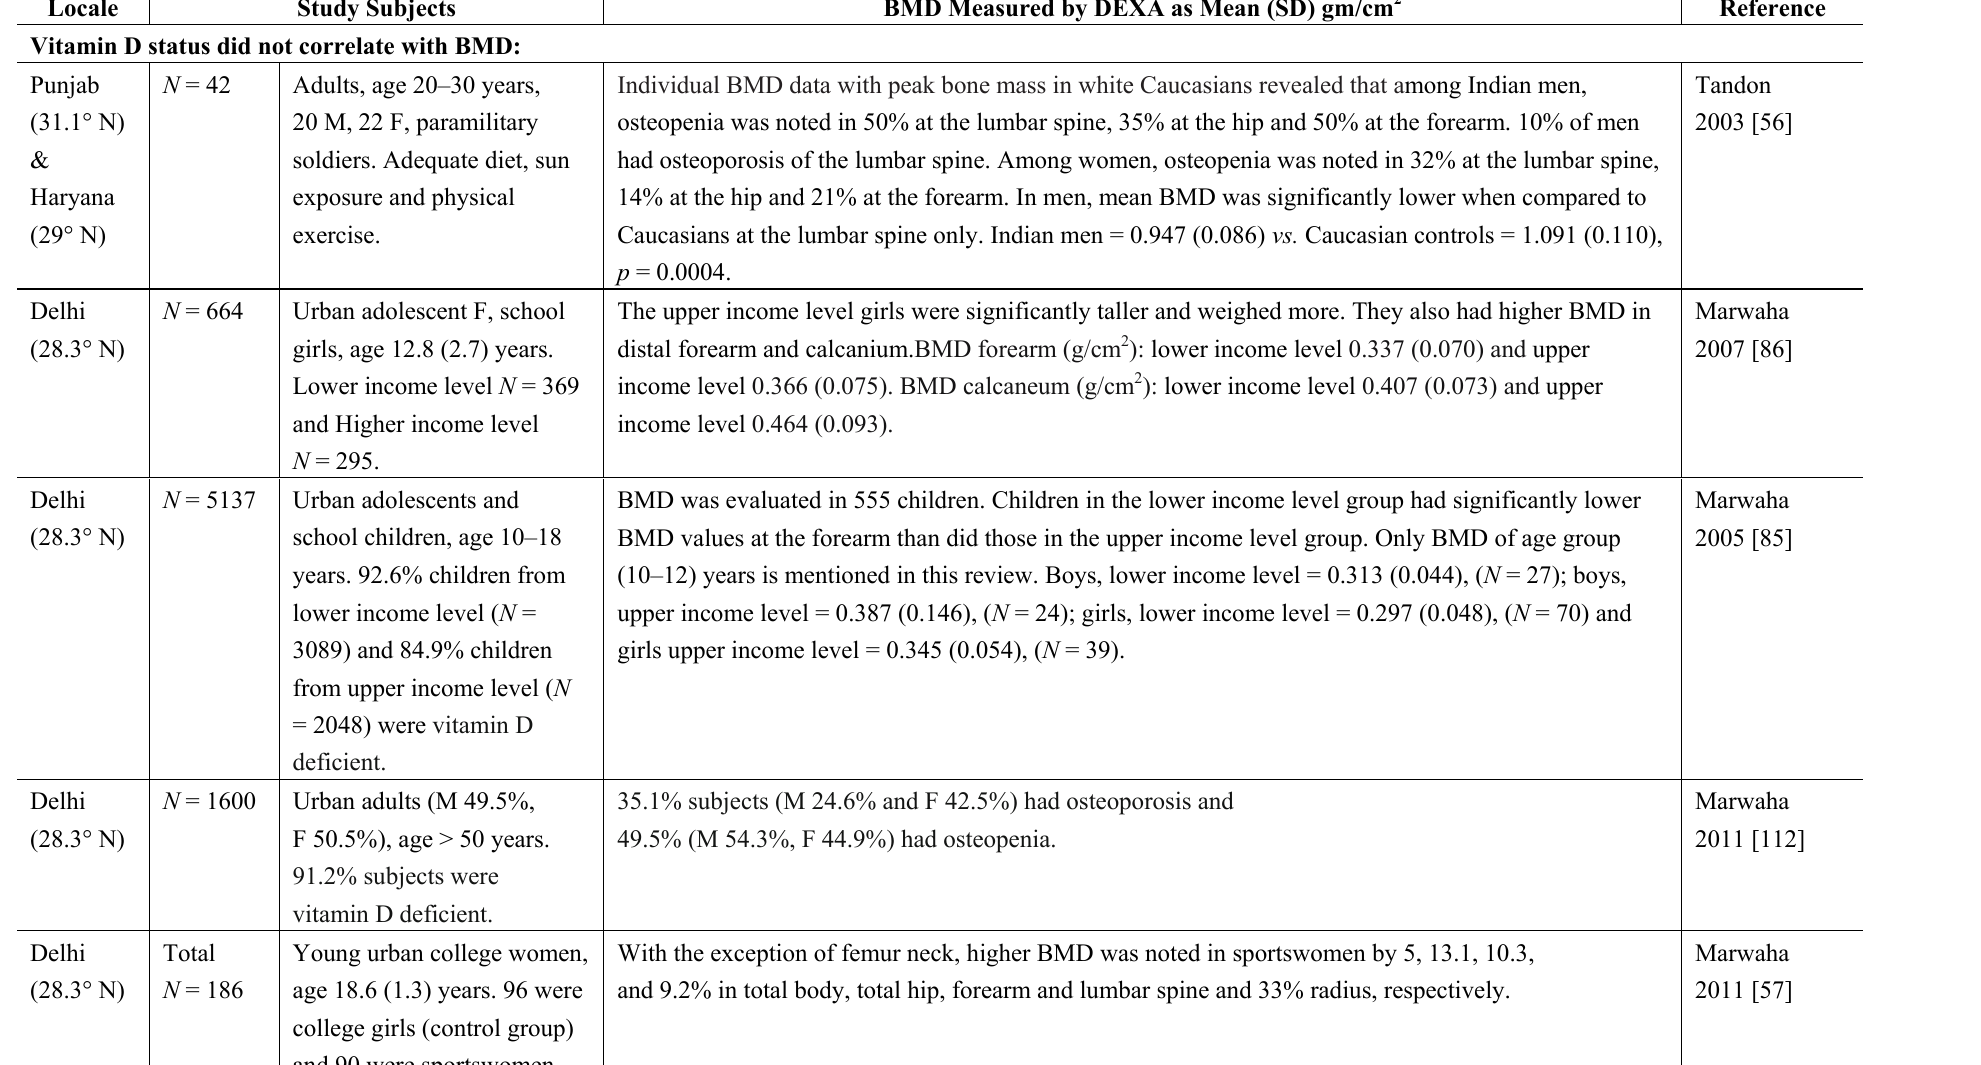
BMD Measured by DEXA as Mean (SD) gm/cm 2